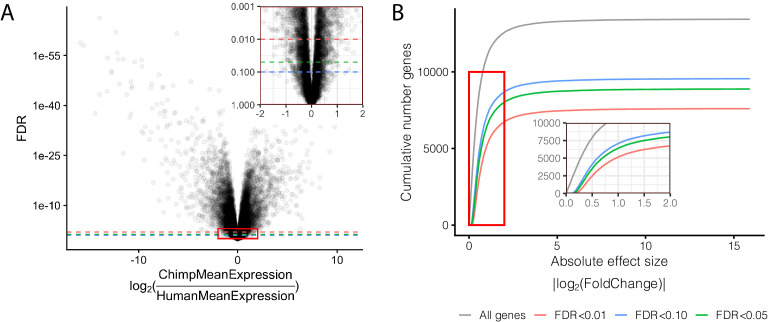
Effect size and significance of differential expression (DE) analysis.(A) Volcano plot of DE genes between human and chimpanzee heart tissue. Inset focuses on the red boxed area to highlight the relationship between expression fold change and DE gene classification at various FDR thresholds. (B) The number of DE genes identified under any given fold change threshold at various FDR thresholds. Full DE results are available in Figure 1—figure supplement 1—source data 1.Figure 1—figure supplement 1—source data 1.Full DE results.